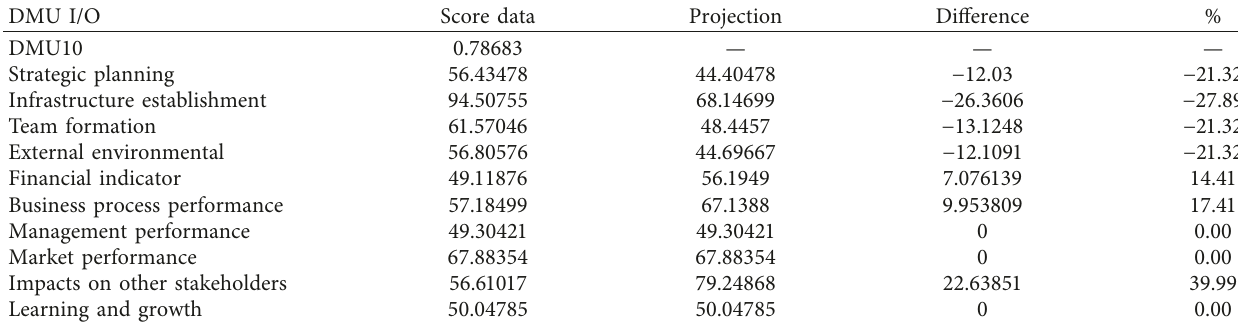
Table 13: Specific improvement measures for